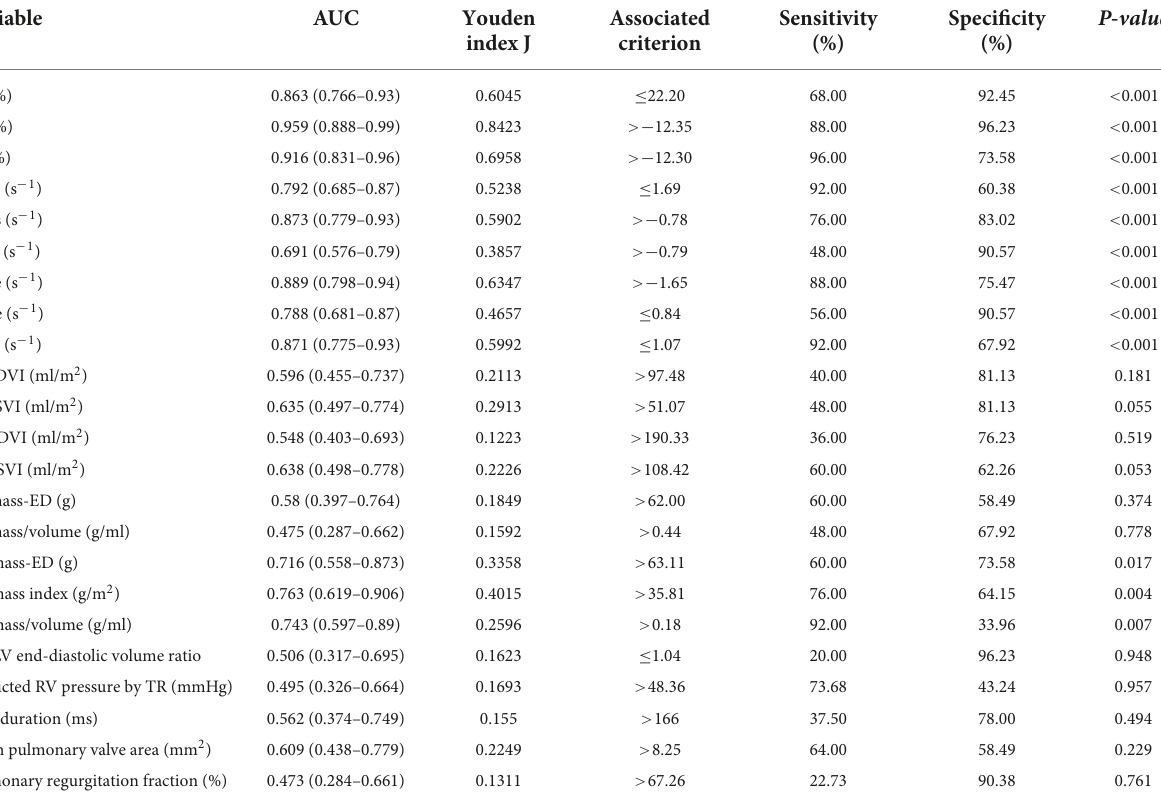
TABLE 3 Receiver operating characteristic (ROC) curve